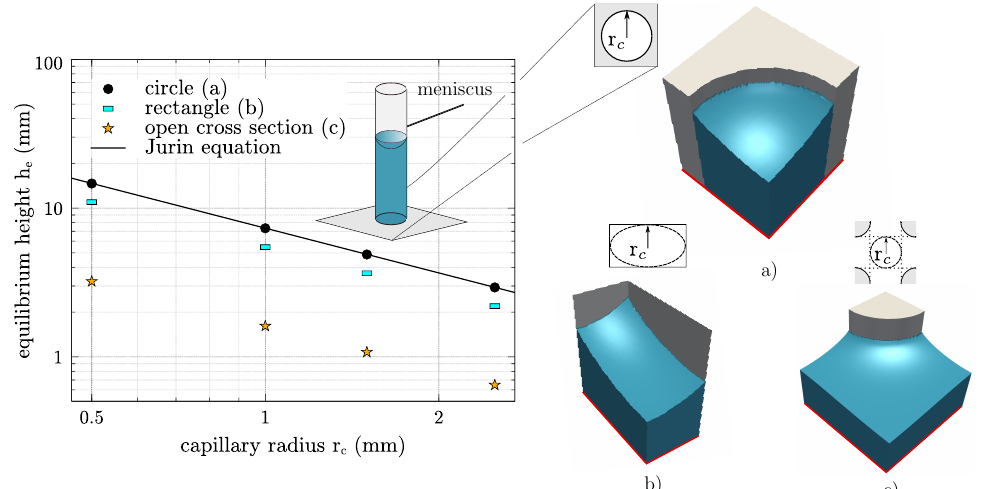
Figure 5. Equilibrium height h e , over capillary radius r c , for three different cross-sectional shapes in log–log scale: ( a ) circle, ( b ) rectangle, and ( c ) open cross section (adapted from [6]). The simulation results are presented by symbols, while the solid line follows Equation (15) for the circular cross section. The capillary radius r c is defined as half of a minimum measurable distance between two boundaries within the cross section. The red line defines the zero level and the Neumann boundary